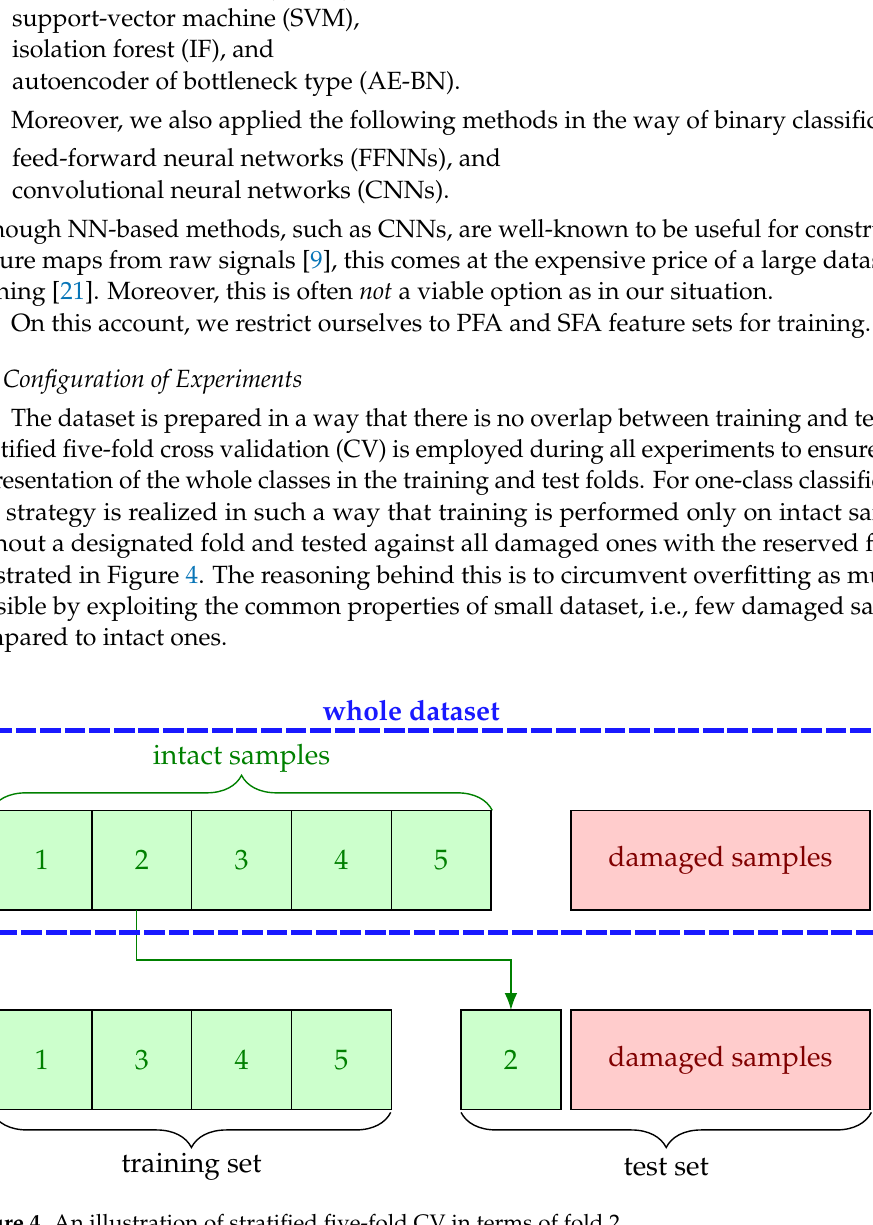
Figure 4. An illustration of stratified five-fold CV in terms of fold